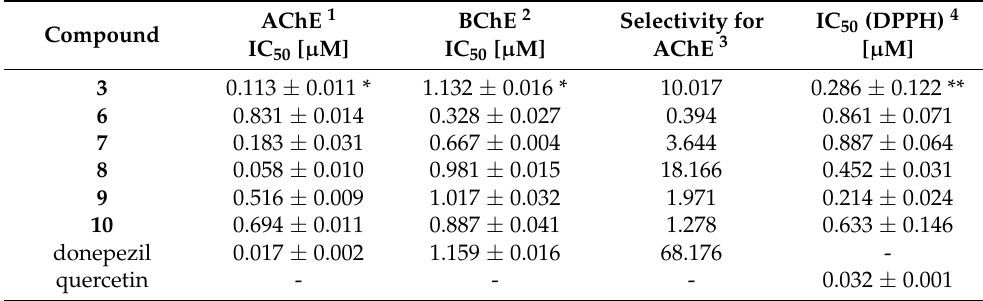
Table 1. In vitro inhibitory concentration of the new compounds and against AChE and BChE (IC 50 , µM), selectivity, and the radical scavenging effect IC 50 (DPPH).